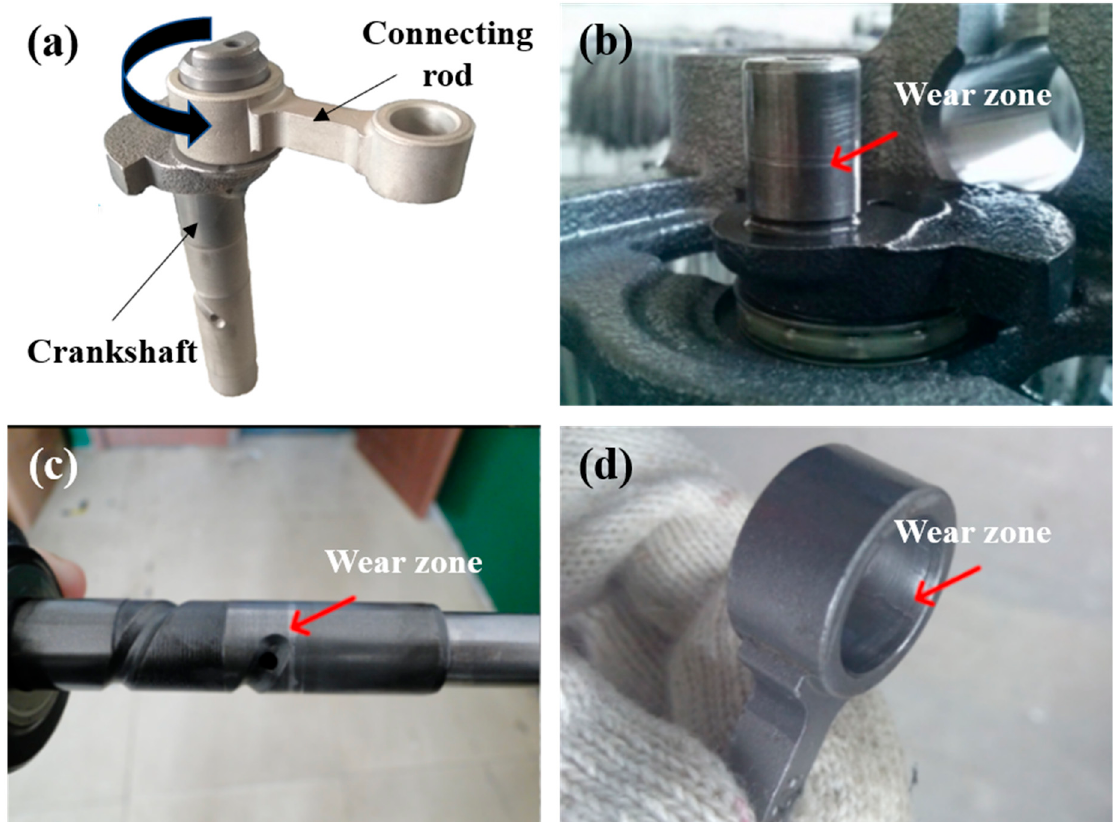
Figure 1. Crankshaft connecting rod failure parts. ( a ) Crankshaft and connecting rod; ( b ) eccentric shaft; ( c ) principal axis; ( d ) connecting rod big ring.